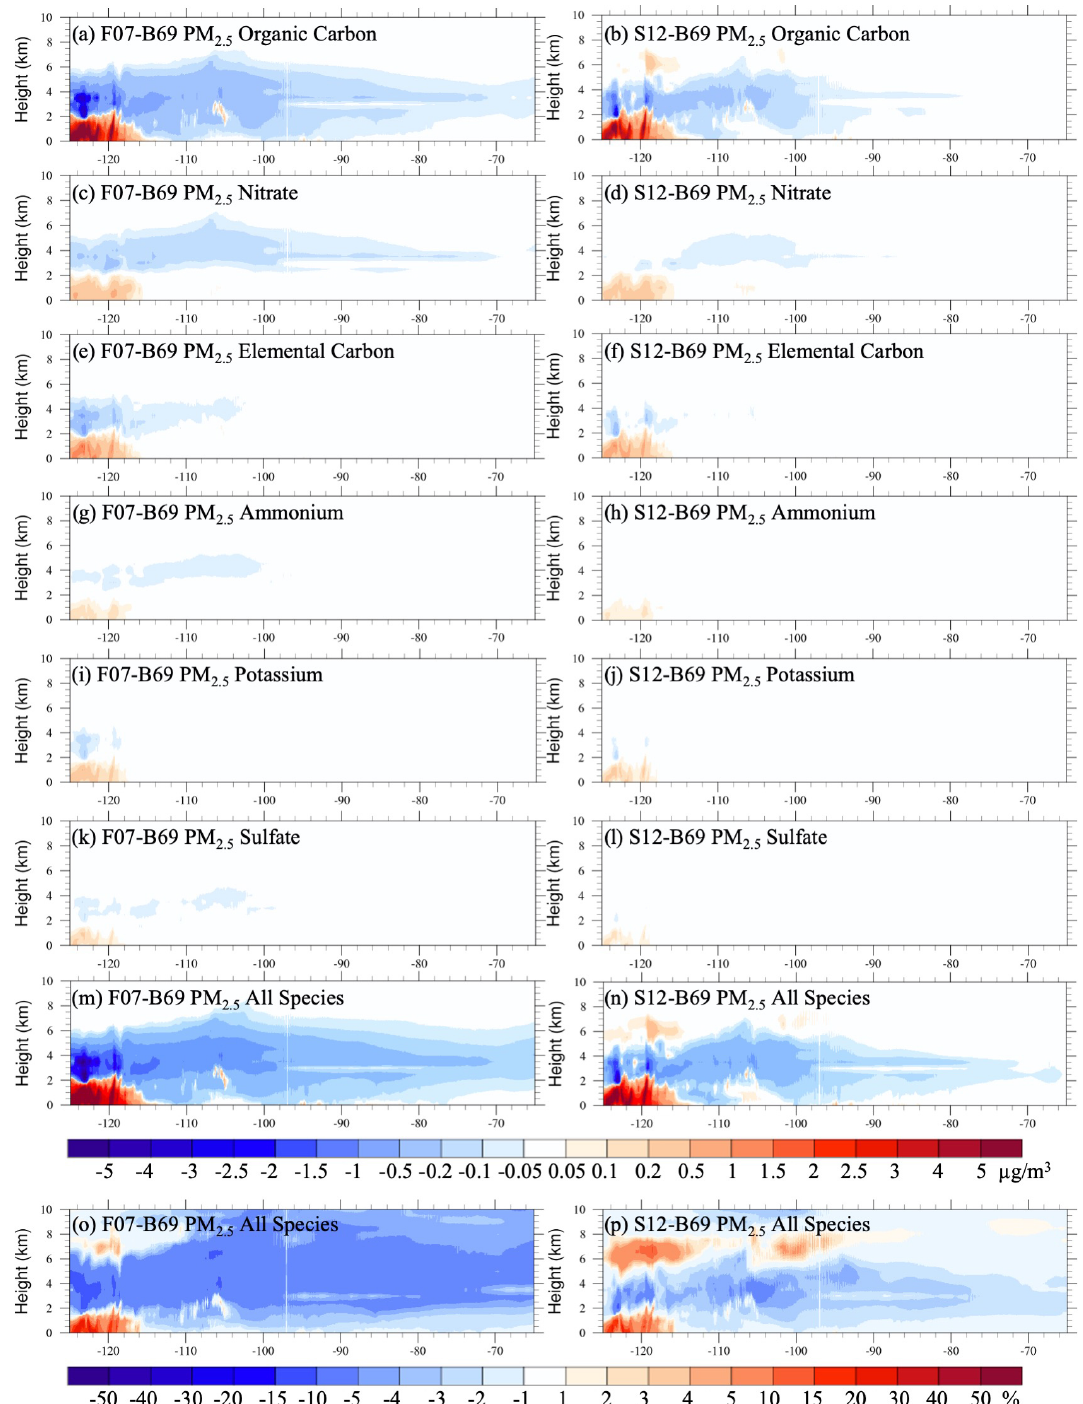
Figure 7. (a–n) Zonal mean difference in predicted concentrations of six major PM 2 . 5 species among the simulations using the B69, F07, and S12 schemes from 1 August to 30 September 2020 for organic matter (a, b) , nitrate (c, d) , elemental carbon (e, f) , ammonium (g, h) , potassium (i, j) , and sulfate (k, l) . The difference in total PM 2 . 5 is displayed by both the absolute values (m, n) and percentage (o, p)